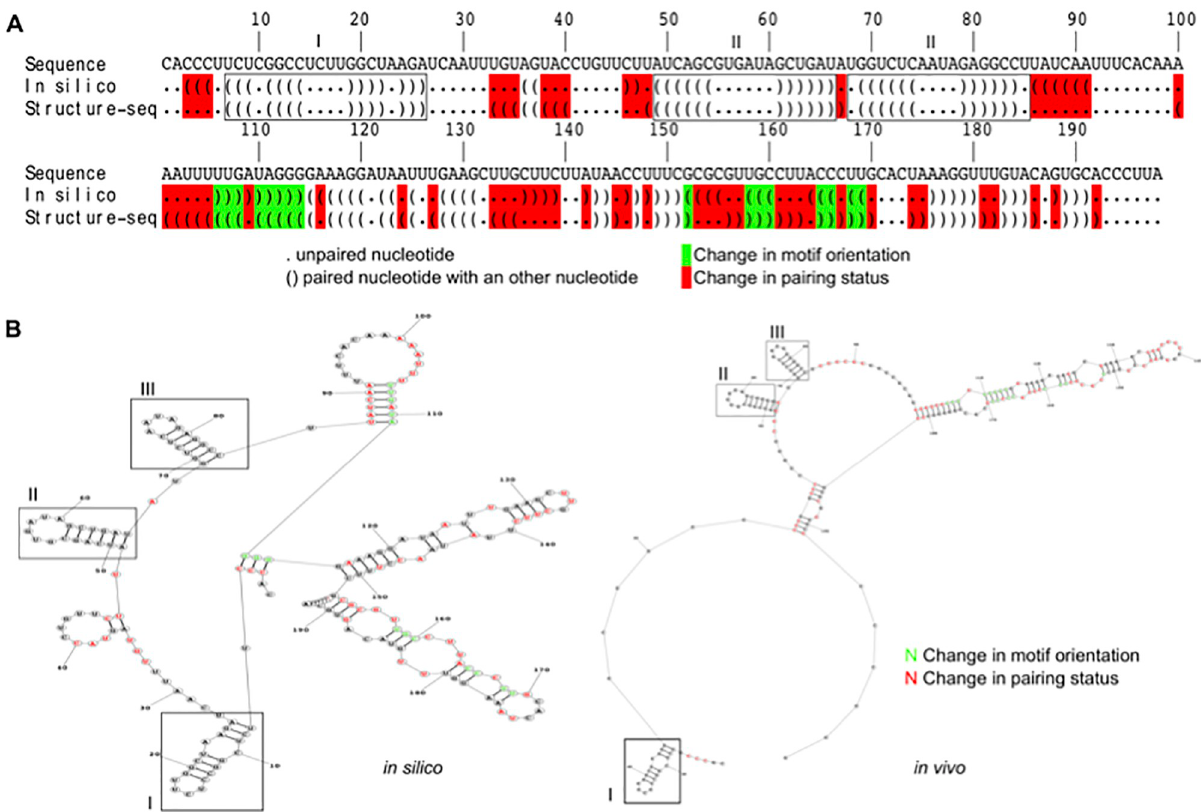
Fig 4. Difference in U2 snRNA structure determined by Structure-seq versus in silico prediction. (A) U2 snRNA (PF3D7_1137000) reactivity sequence alignment, comparing in vitro probing using NAI and in silico prediction using the same constraint parameters. The first line shows the nucleotide sequence, the second line shows the in silico predicted dot/bracket sequence and the third line, the Structure-seq dot/bracket sequence extracted from reactivity measurement. A dot shows a nucleotide not paired with any other nucleotide. An open bracket shows a nucleotide paired with another and starting a structural motif, while a closed bracket shows a nucleotide paired with another but finishing a structural motif. Red-highlighted dot or bracket indicates a change of pairing between the NAI and in silico predicted structural sequence. A green-highlighted bracket indicates a change in motif orientation between the NAI and in silico predicted structural sequence. Boxes with roman numerals indicate the conserved structures between the two shapes. (B) U2 snRNA structure predicted in silico from RNA sequence alone, on the left, and with the addition of reactivity data on the right. The red and green colouring have the same meaning as in (A).